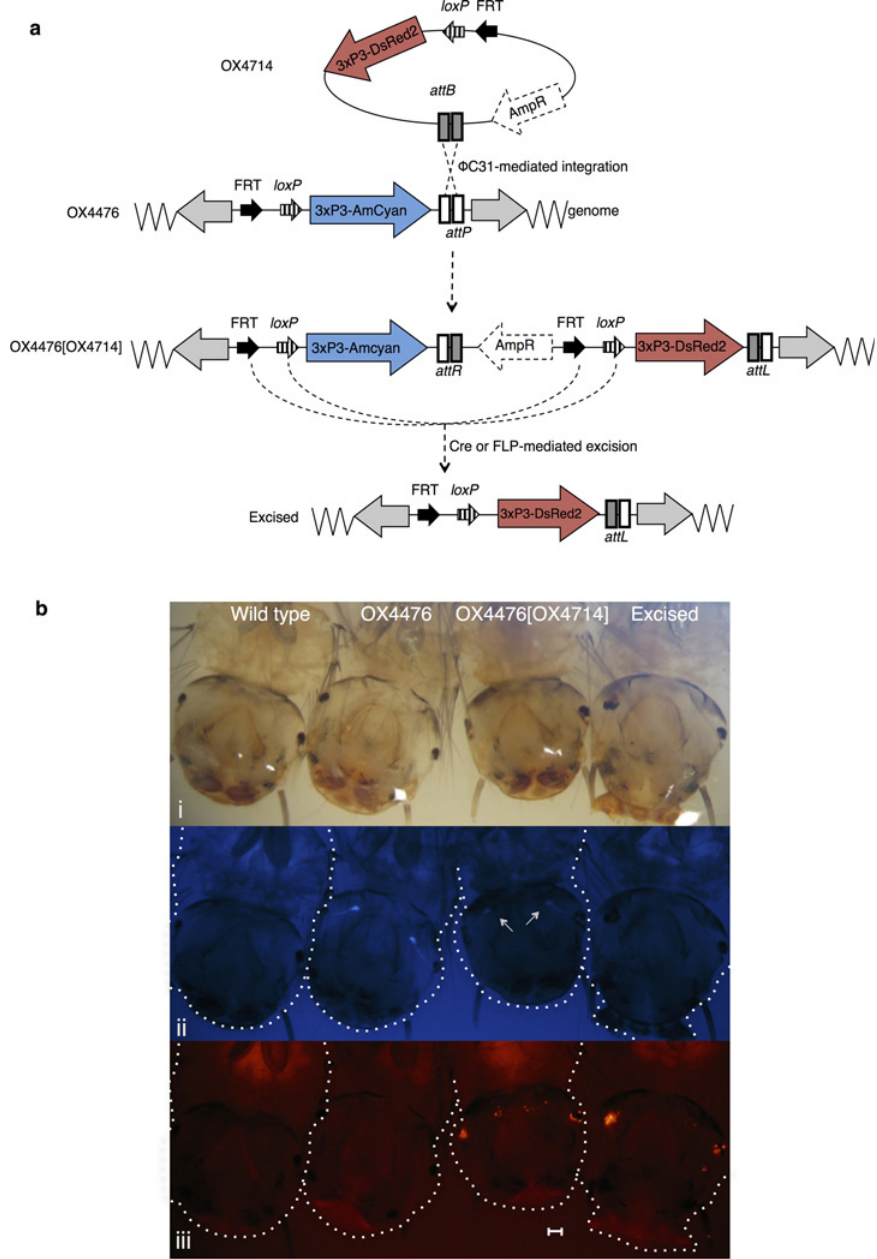
Fig 2. iRMCE in Ae . aegypti . (a) Schematic diagram of iRMCE in Ae . aegypti and (b) corresponding fluorescent phenotypes in fourth instar Ae . aegypti larvae following OX4714 injections. Black arrows indicate engineered FRT and loxP sites present in donor and acceptor constructs; AmpR represents the plasmid backbone sequences, which includes the ampicillin-resistance gene; grey arrows indicate piggyBac ends. The donor plasmid ’ s 3xP3-DsRed2 cassette is exchanged for the docking construct ’ s 3xP3-Amcyan. Larvae are shown under (i) white light, (ii) cyan, and (iii) red excitation light and filters. Images show complete exchange of the 3xP3-AmCyan cassette (OX4476), by integration of 3xP3-DsRed2 (seen in OX4476 [OX4714]), and excision of the 3xP3-AmCyan marker ( ‘ excised ’ larva). There was reduced expression of the docking cassette ’ s 3xP3-AmCyan marker following Φ C31- att integration (white arrows: panel (ii), OX4476 [OX4714]). Images (i-iii) were taken under the same magnification. Scale bar represents 0.5 mm. White dashed lines outline